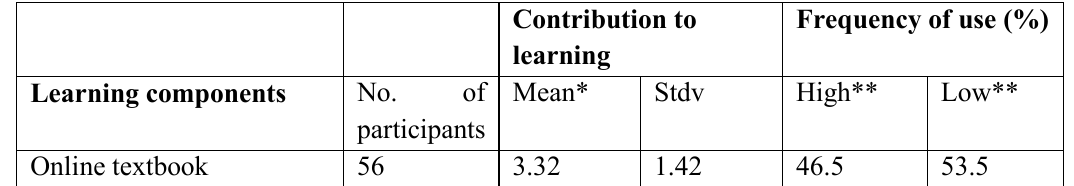
Students’ Attitudes toward the Pedagogical Value of Various Instructional and Learning